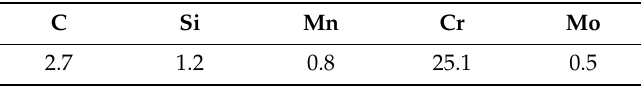
Table 1. Chemical Composition (% by